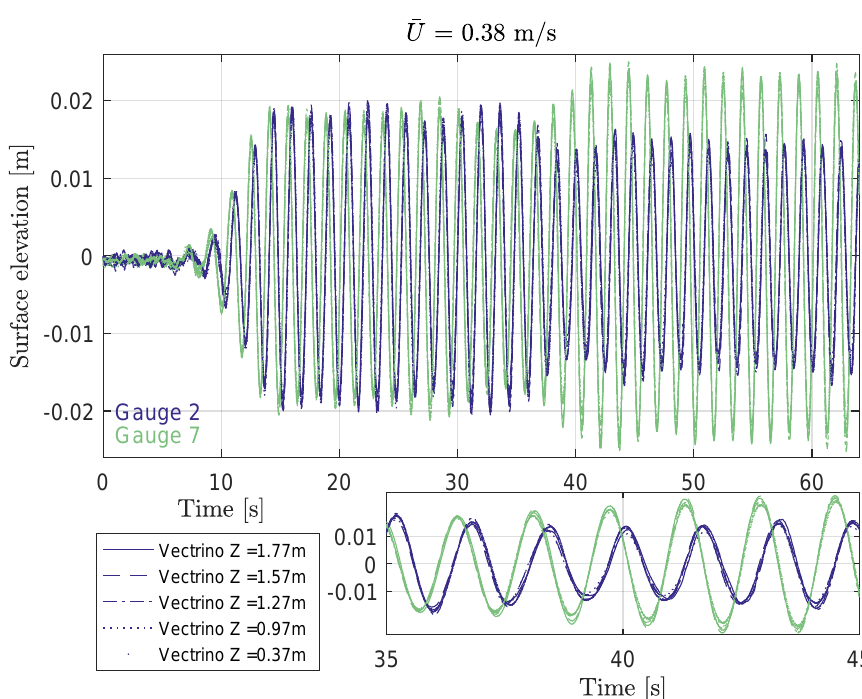
Figure 7. Example time series of regular wave, Sea State 3, shown with five repeats. Gauges 2 and 7 are displayed on the graph. Wave Repeats 1–5 correspond to five z -positions of the Vectrino as shown in the legend.